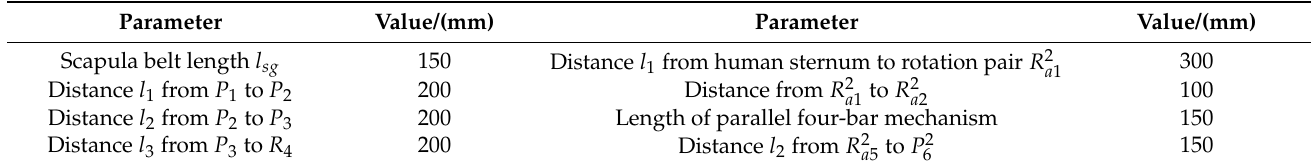
300 a 1 100 to R 2 a 2 a 1 to P 2 a 5